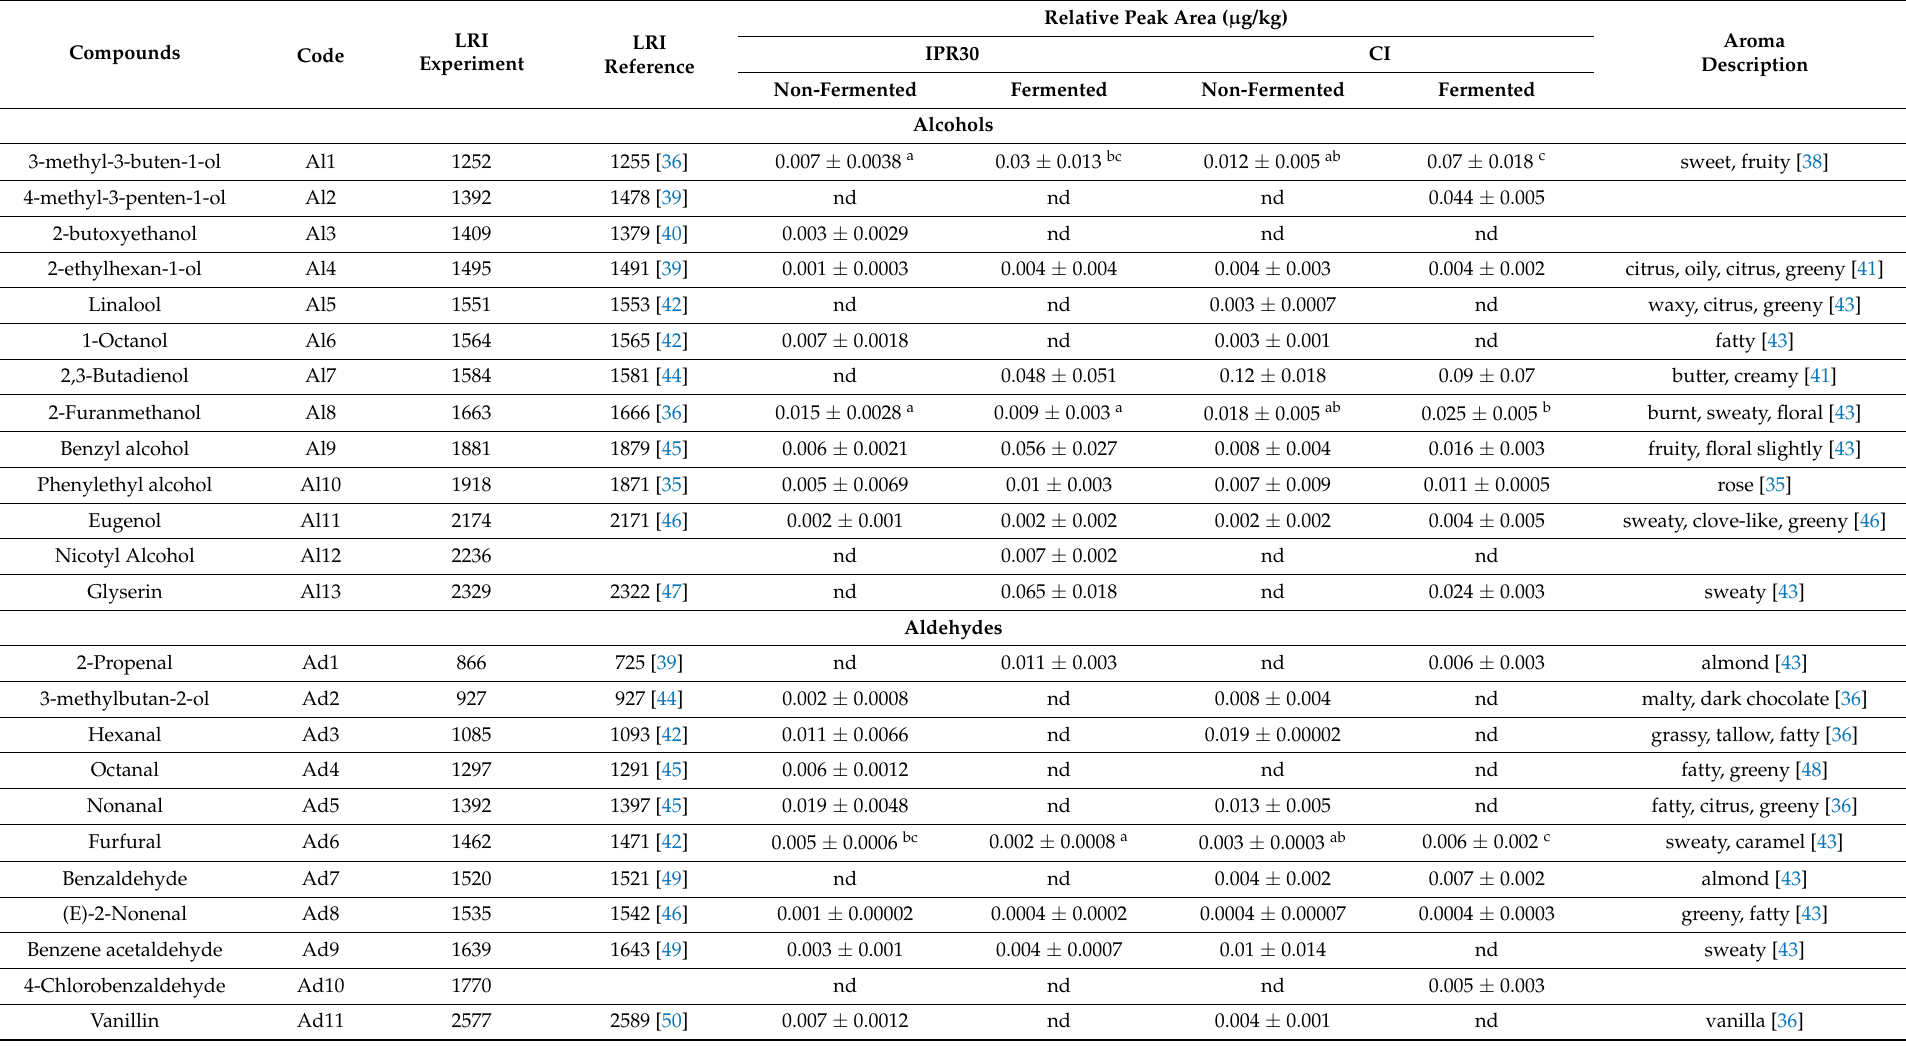
Table 2. Volatile compounds identified in fermented and non-fermented RB of IPR30 and